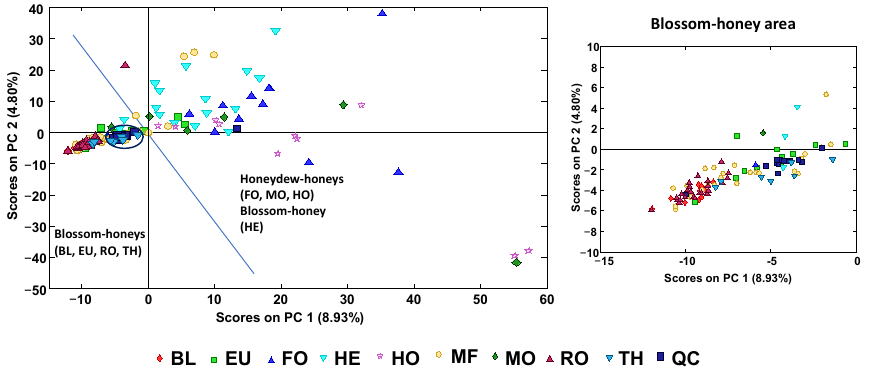
Figure 2. PCA score plot of PC1 vs. PC2 when using non-targeted LC–HRMS fingerprints as honey chemical descriptors. Blue line separates the blossom and honeydew honey (with HE blossom) areas. The blossom honey area is extended on the right plot. BL: orange/lemon blossom; EU: eucalyptus; FO: forest; HE: heather; HO: holm oak; MF: multi-floral; MO: mountain; RO: rosemary; TH: thyme; QC: quality